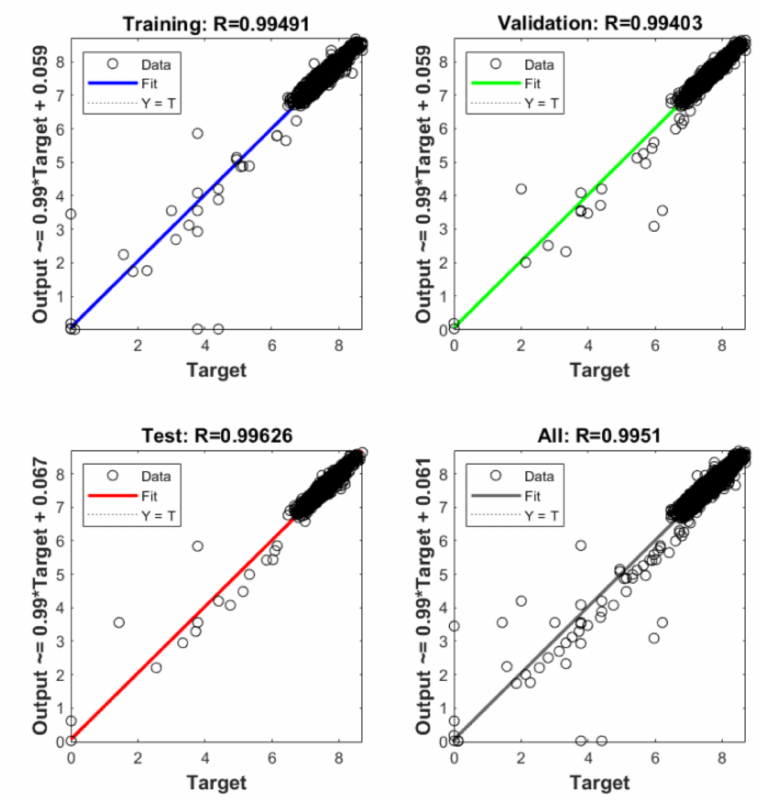
Figure 7. Regression diagram of training validation test samples after